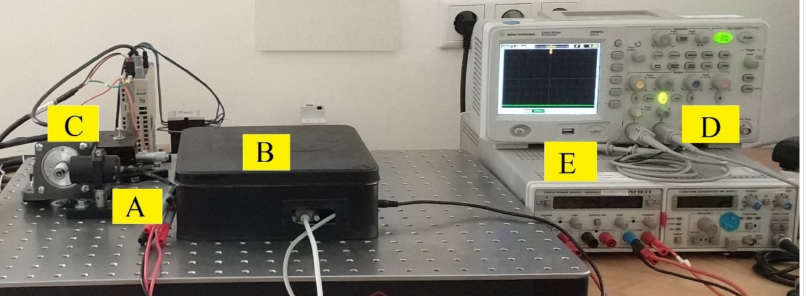
Figure 13. Test system A: Sensor head; B: laser driver + preprocessing circuit; C: Servo motor; D: Oscilloscope; and E: power supply [17] (Reprinted with permission from [18] © The Optical